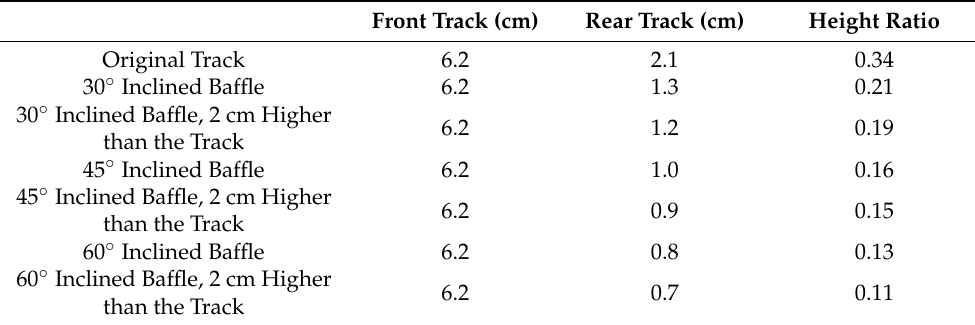
Figure 8. Laboratory experiment for preventing sand deposition on railway tracks. Table 3. Laboratory result.